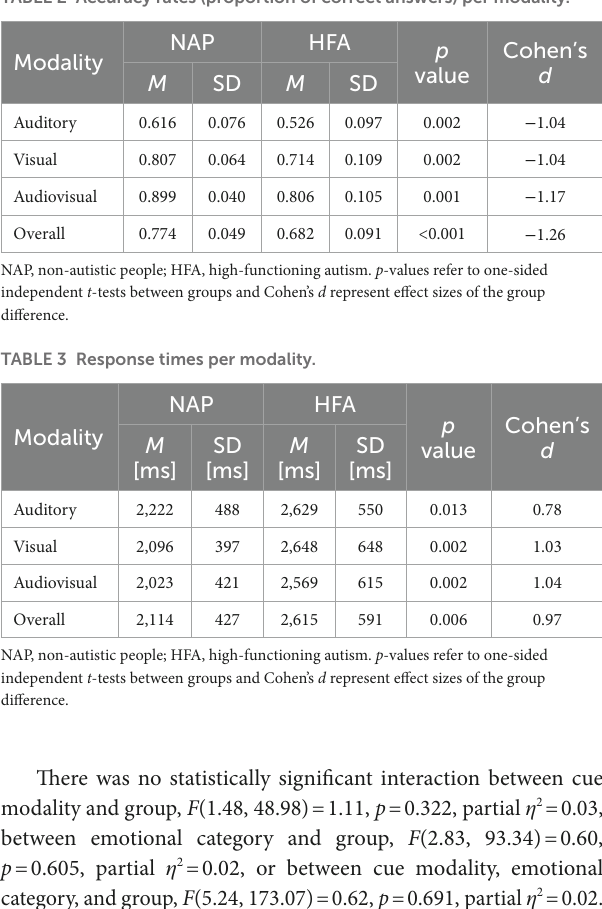
TABLE 2 Accuracy rates (proportion of correct answers) per modality.